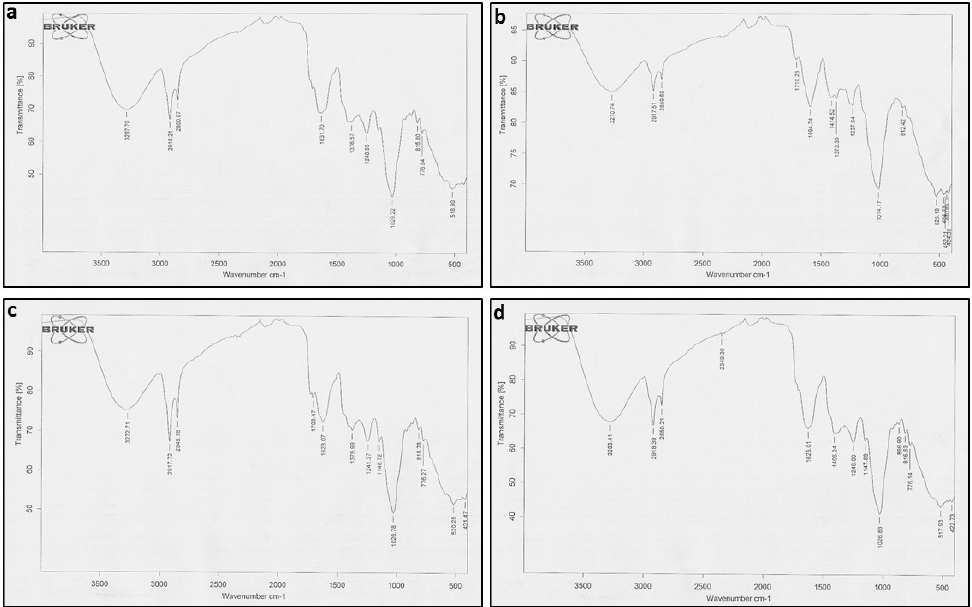
Figure 3. FTIR spectra of different lines of Ajuga bracteosa ( a ) WT ( b ) ABRL1 ( c ) ABRL2 ( d ) ABRL3. These spectra revealed that ABRL1 has 11 major peaks between 525.19 and 3270.74 nm,